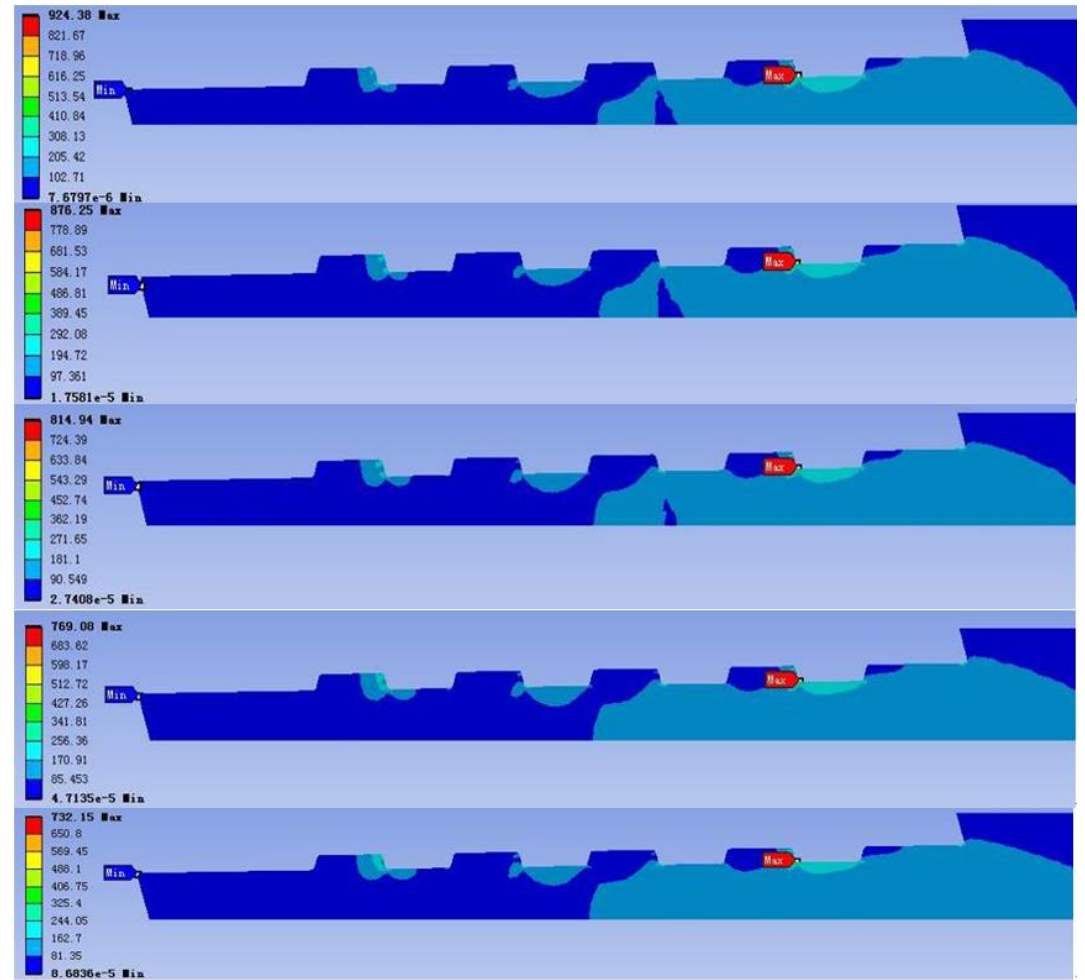
Figure 10. The stress nephogram of the external thread of the confined probe joint (the inner diameters from top to bottom are 68, 67.5, 67, 66.5, and 66mm,